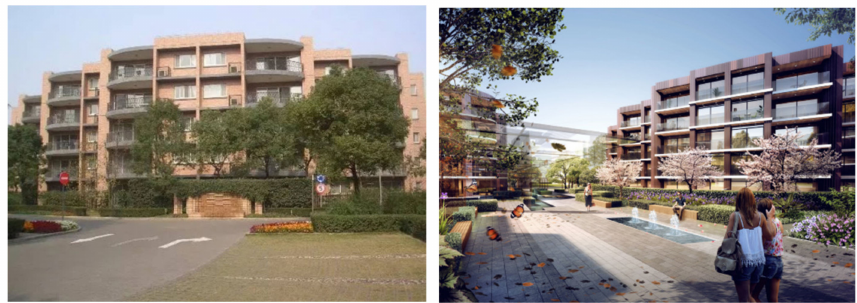
Figure 4. Existing building ( left ) and the rendering of retrofitting design ( right